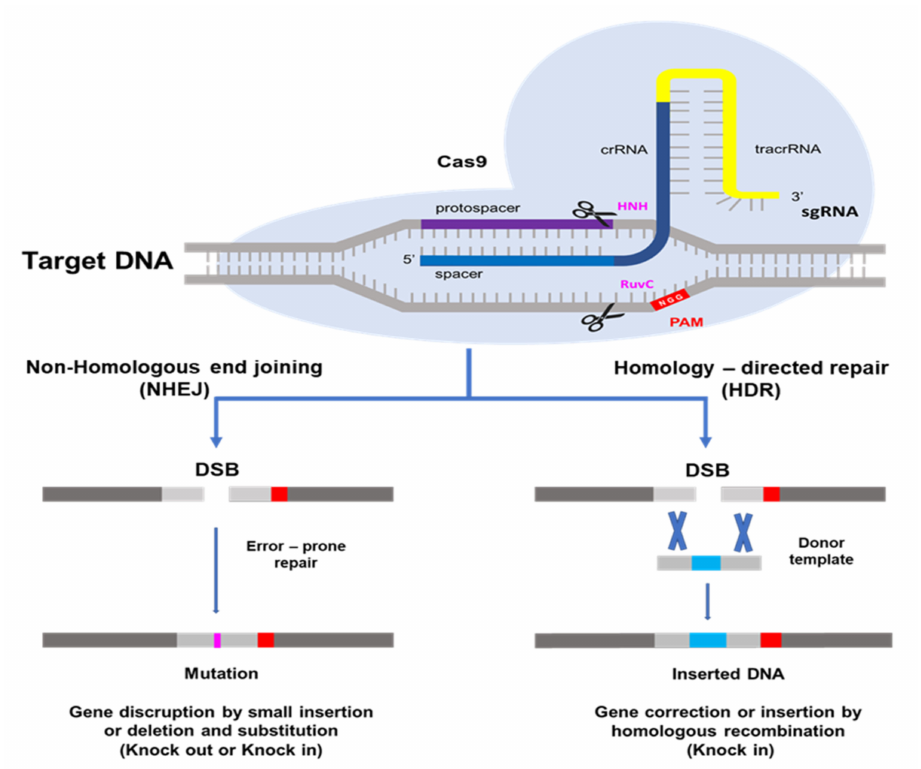
Figure 1. Schematic picture of genome editing mediated by the CRISPR/Cas9 system. The Cas9 protein, which is guided by a desired single-strand guide (gRNA), cuts the double-stranded DNA and makes a double strand break (DSB). Subsequently, DNA repair occurs through either Non- homologous end-joining (NHEJ) or homology directed repair (HDR) pathways (Modified from Doudna JA, Charpentier E, 2014)